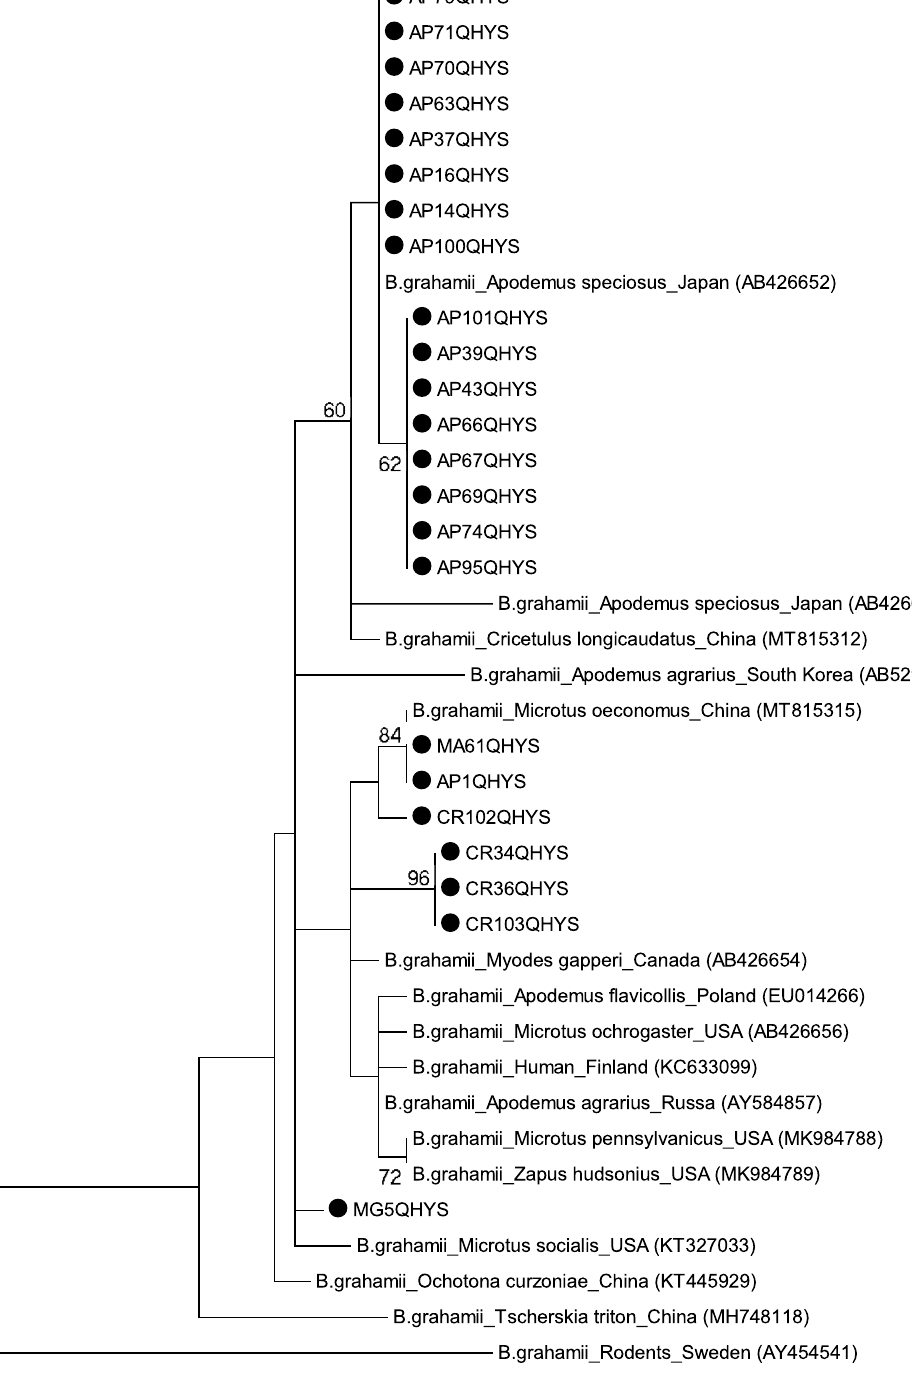
Figure 4. Traceability analyses of B . grahamii based on gltA gene. The tree was constructed by using the maximum-likelihood (ML) method with the Kimura 2-parameter model, bootstrap values calculated with 1000 replicates in MEGA version 7.0 (https:// www. megas oftwa re. net). The sequences detected in this study are indicated with black